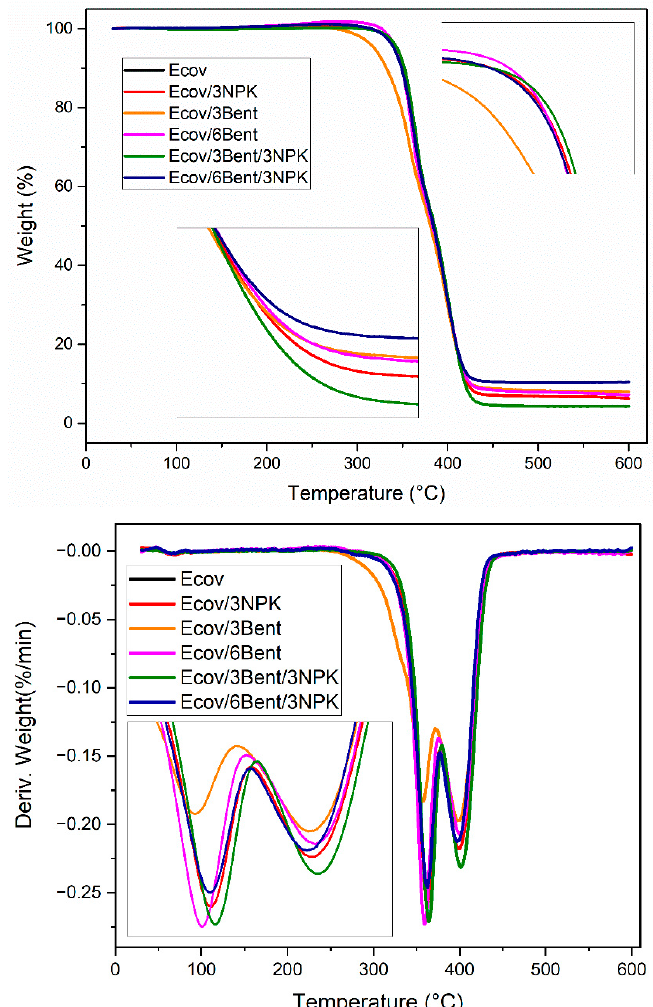
Figure 4. TGA of the systems: Ecov; Ecov/3NPK; Ecov/3Bent; Ecov/6Bent; Ecov/3Bent/3NPK; Ecov/6Bent/3NPK.